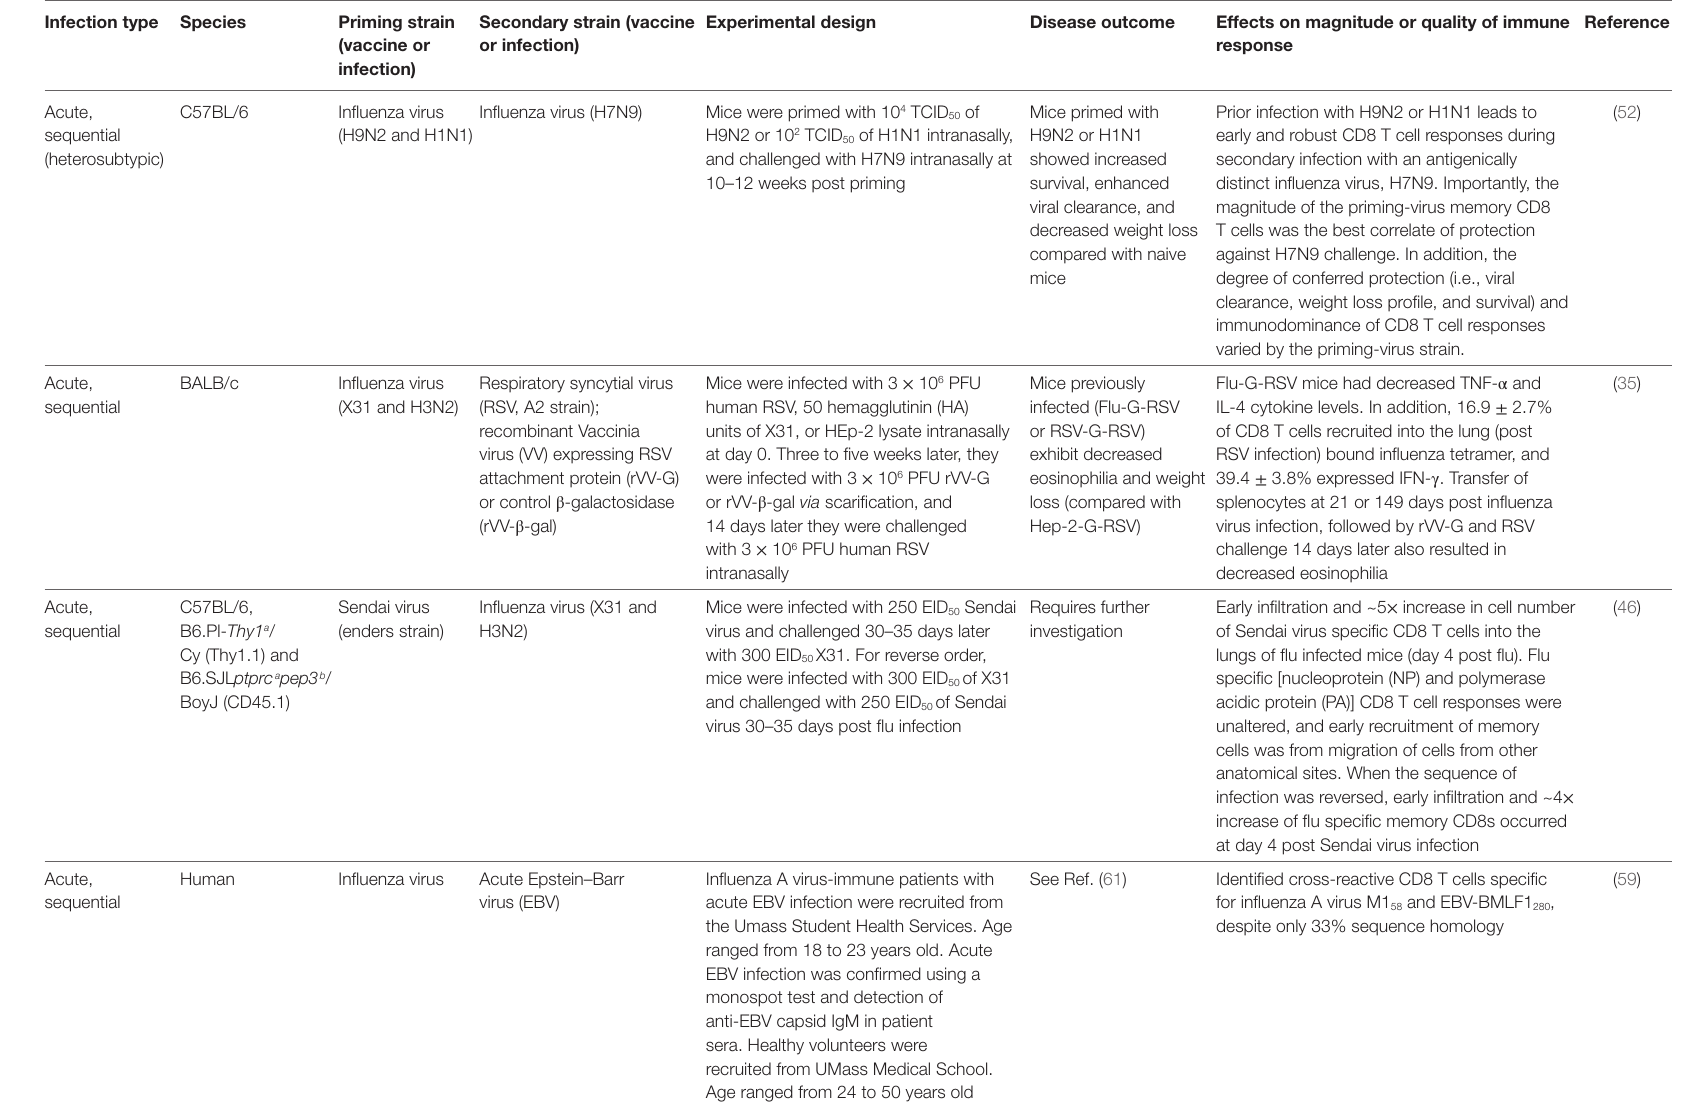
TAbLe 2 | Overview of studies showing heterologous acute sequential or chronic co-infection can alter influenza virus